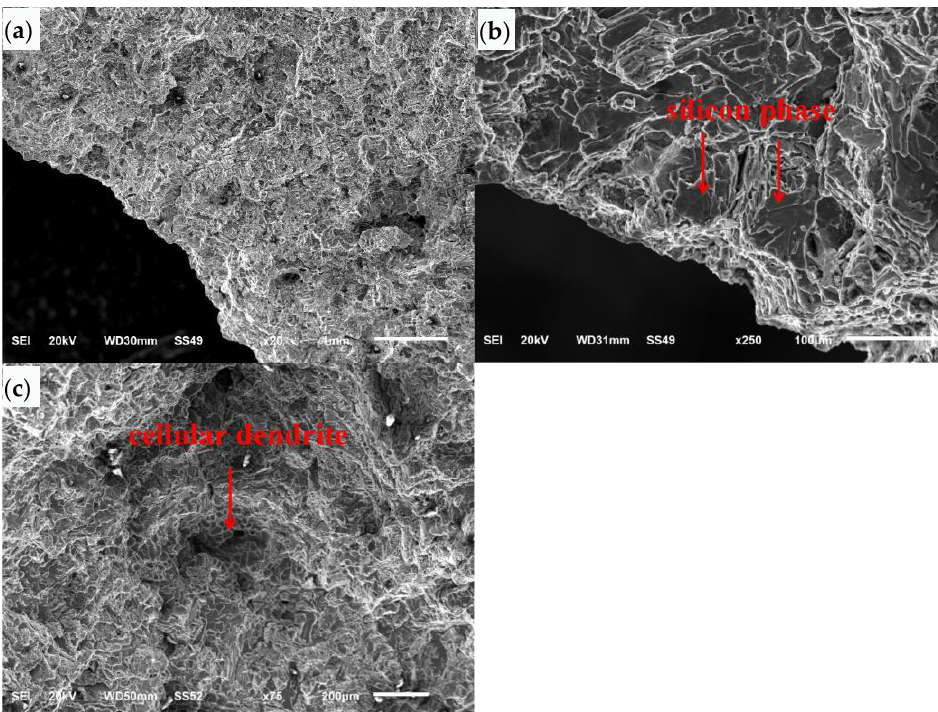
Figure 9. SEM morphology of initiation zone and propagation zone of the safety buckle: ( a ) low magnification, ( b ) high magnification, ( c ) section expansion area.